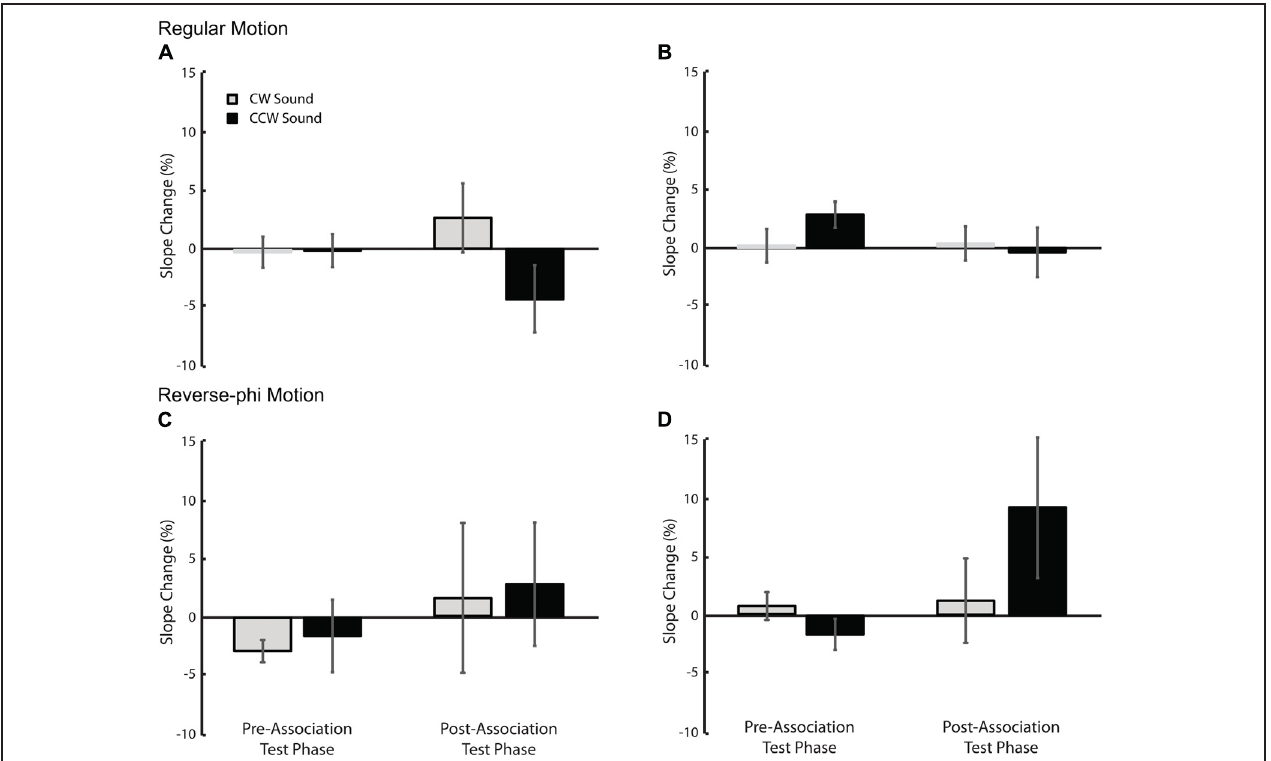
FIGURE 6 | The changes in slope values (in units of motion coherence level) relative to the visual-only condition. Top panel: Experiment 1 (A) and Experiment 2 (B) regular motion data. Bottom panel: Experiment 1 (C) and Experiment 2 (D) reverse-phi motion data. Error bars indicate + SEM. Other conventions are the same as those in Figures 3 and 5